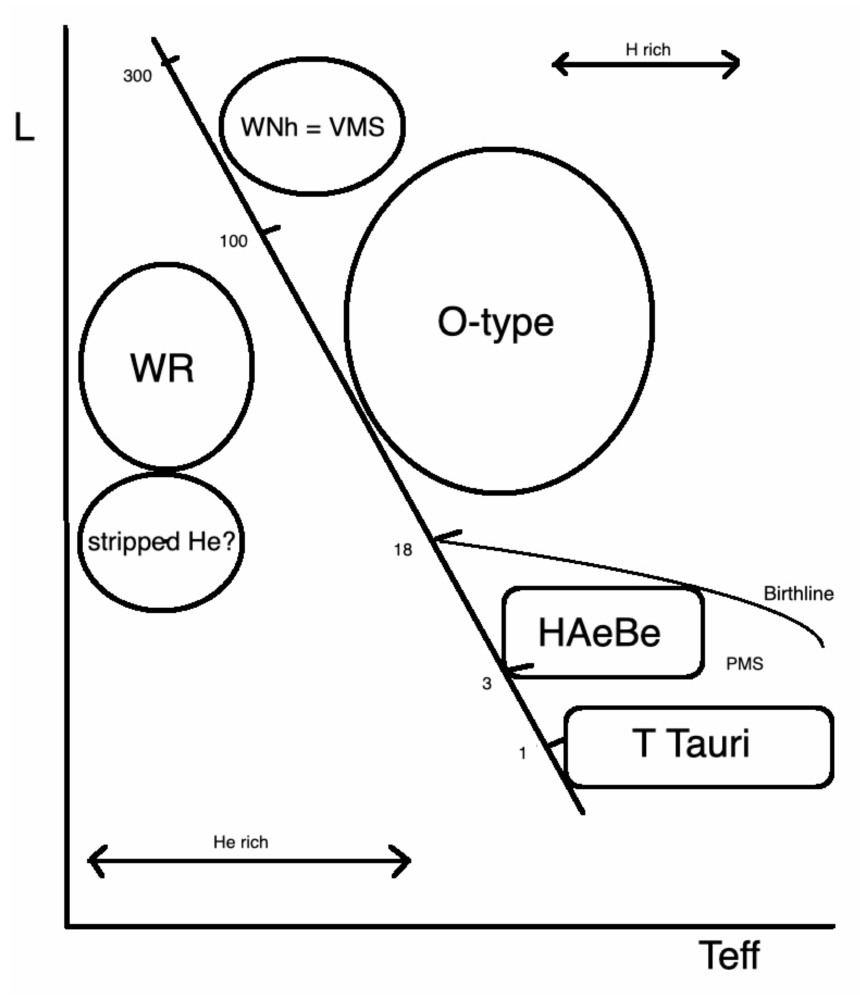
Figure 1. Schematic HRD including groups of objects discussed in this overview. Indicative masses are shown to the left of the main sequence. The groups of PMS that we discuss are T Tauri and Herbig Ae/Be stars. The He-rich stars are the classical WR stars and the potential stripped He stars. Massive stars do not have a visible PMS phase, i.e., they are above the birthline. The boundary between canonical massive O stars and VMS is around 100M (cid:12)